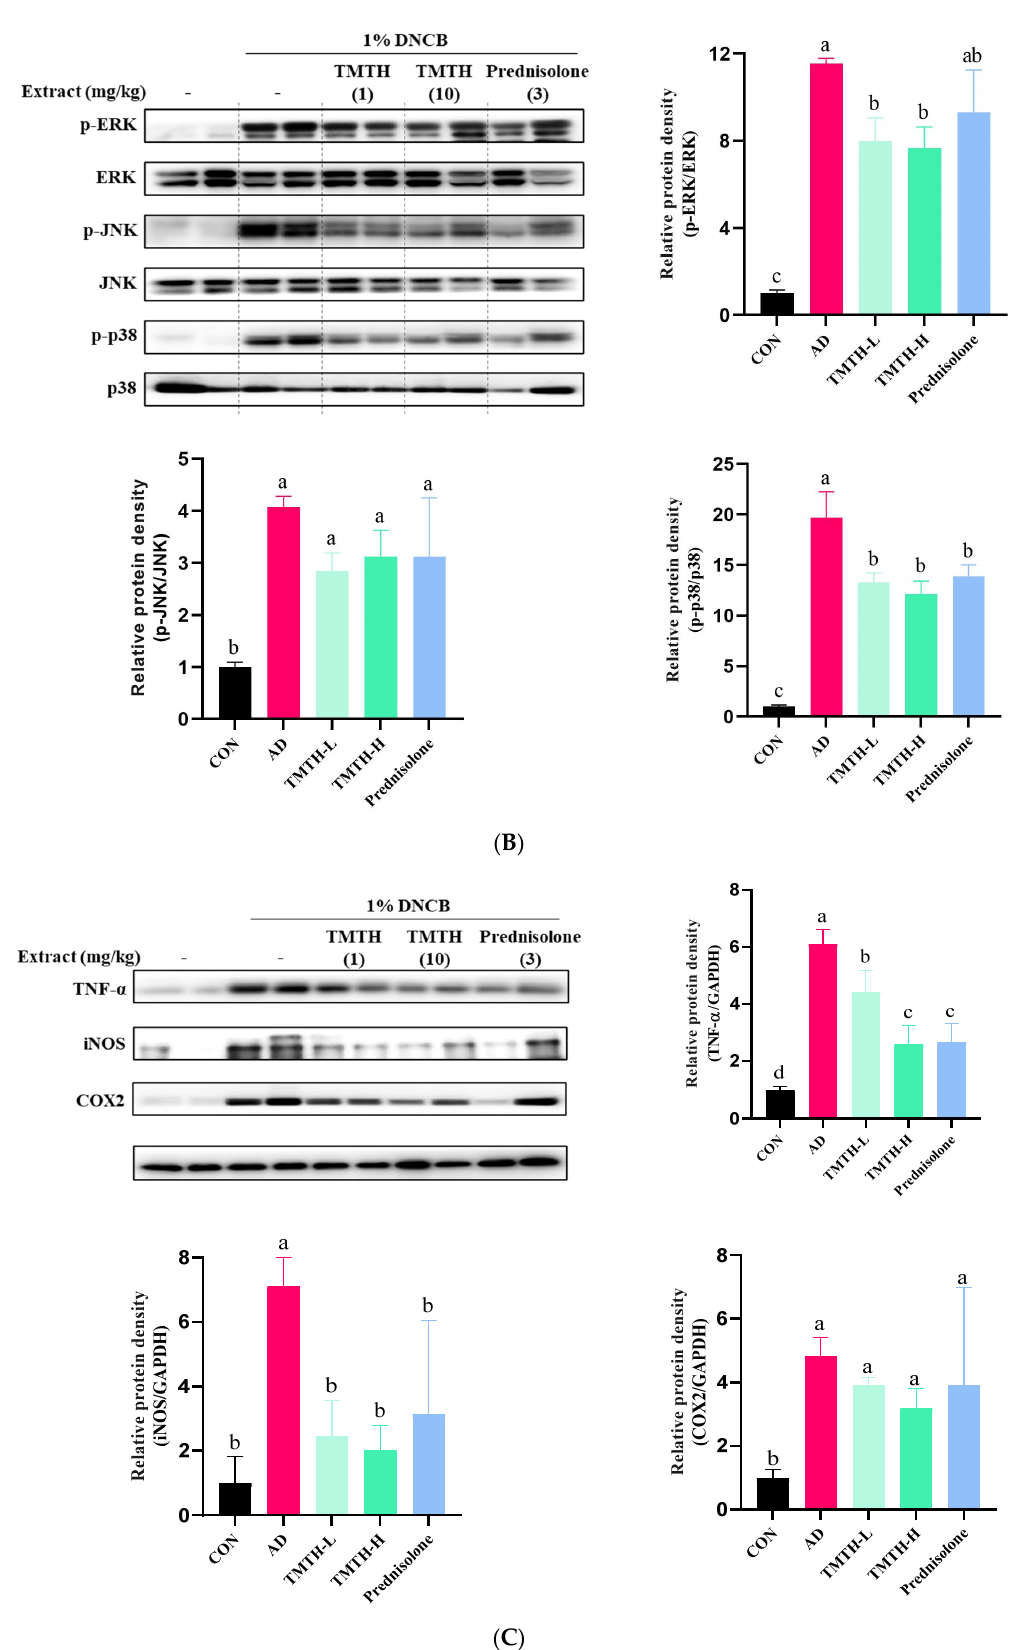
Figure 5. Effects of Tenebrio molitor trypsin hydrolysate (TMTH) on the protein expression levels of inflamed dorsal skin. ( A ) Effect of TMTH on myeloid differentiation primary response 88